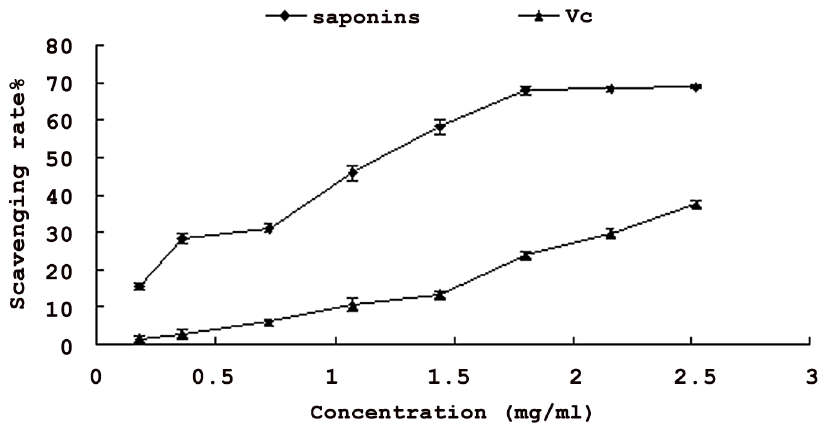
Figure 5. Hydroxyl radical-scavenging activity of the saponins and Vc. Each value is expressed as mean ± standard deviation (n=3).